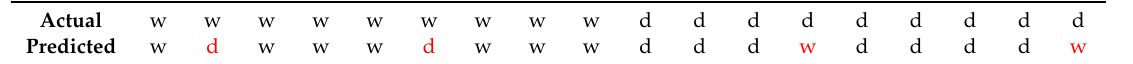
Table 2. An example of a misclassified context by the